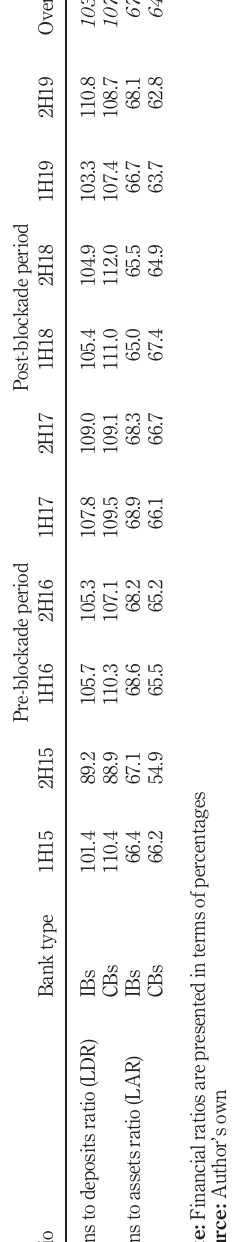
Table 5. Period-and-group- wise comparison of bank liquidity